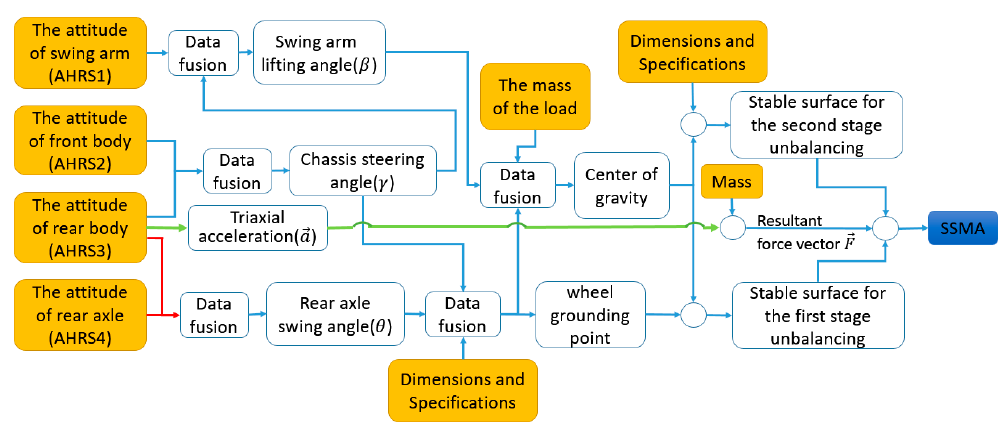
Figure 8. SSMA measuring principle.